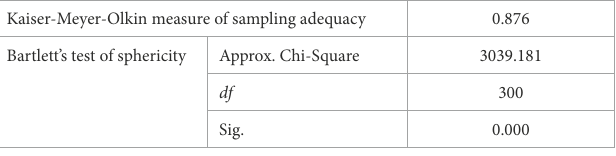
TABLE 2 KMO and Bartlett’s test.